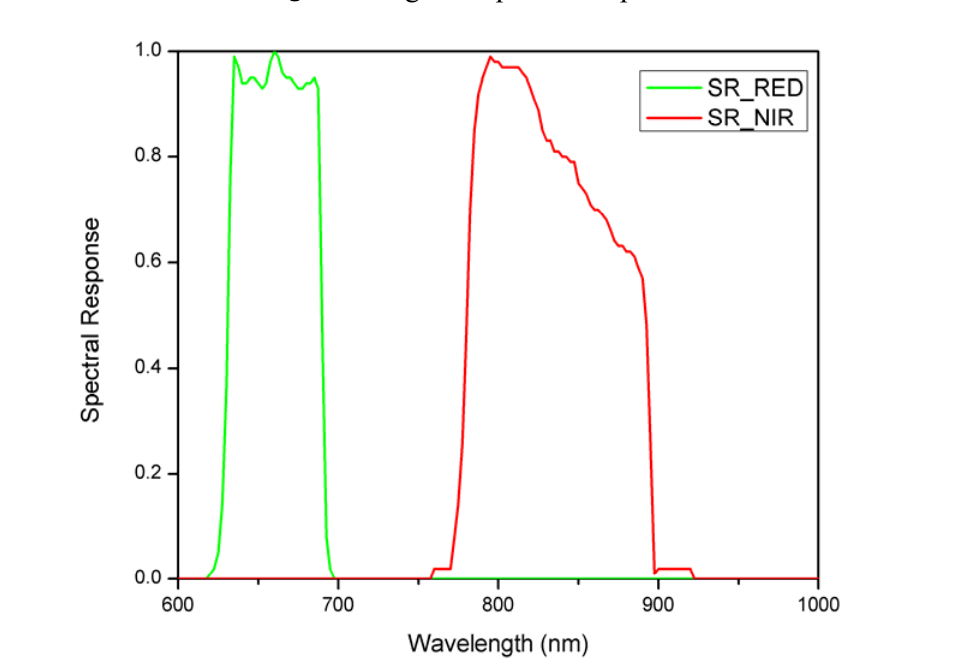
Figure 2. AgCam spectral